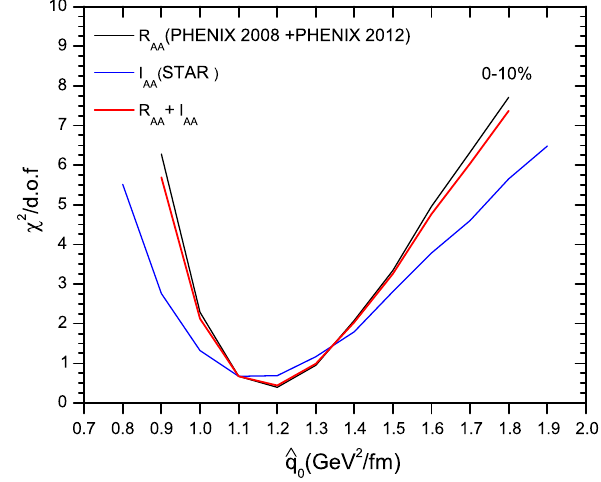
Fig. 2 Global χ 2 analysis for single hadron and (or) dihadron nuclear suppression factors in Au+Au collisions at